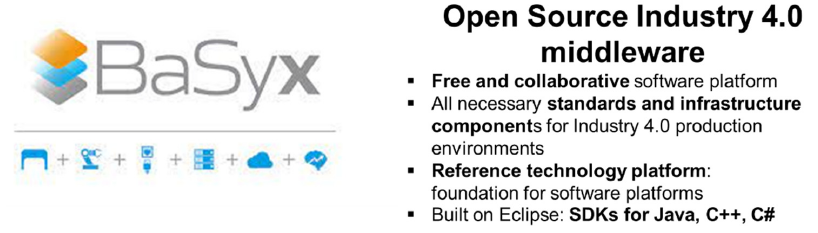
Figure 3. BaSyx–Open-Source Middleware (Own Illustration).